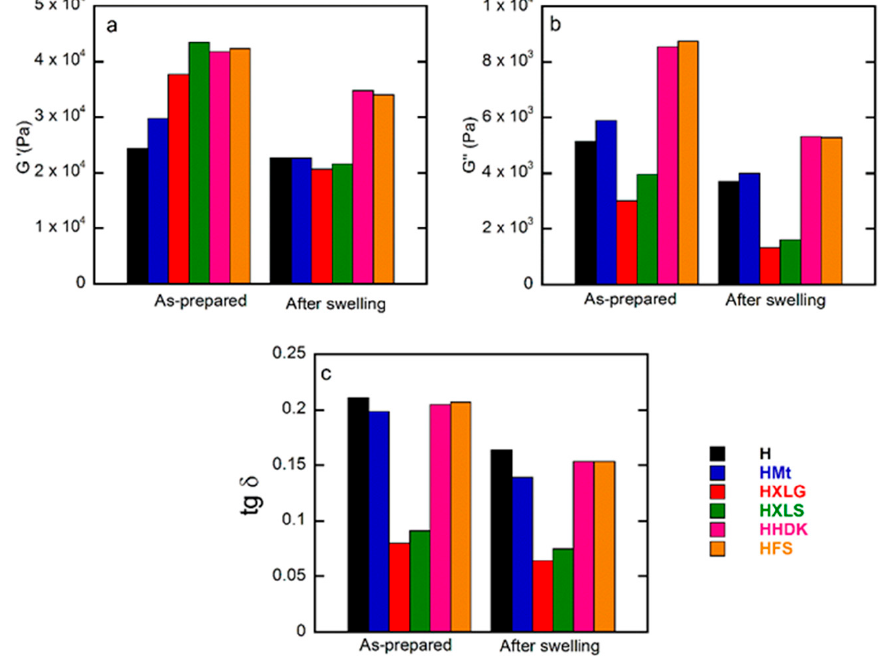
Figure 7. Frequency sweep rheological measurements on both as-prepared and equilibrium-swelled (pH = 5.4) hydrogels: ( a ) storage modulus; ( b ) loss modulus; ( c ) loss factor. Values obtained at 1 Hz.